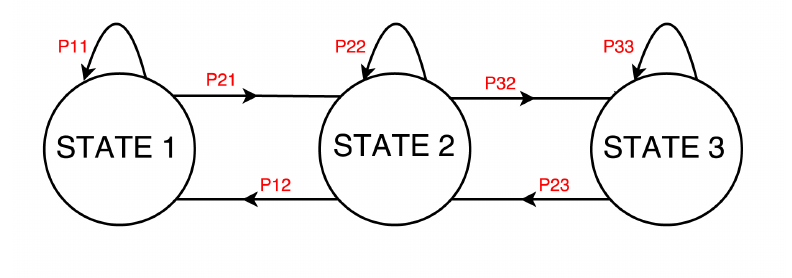
Figure 3. Example of a State Machine with associated transition probability modeling a washing machine operation.